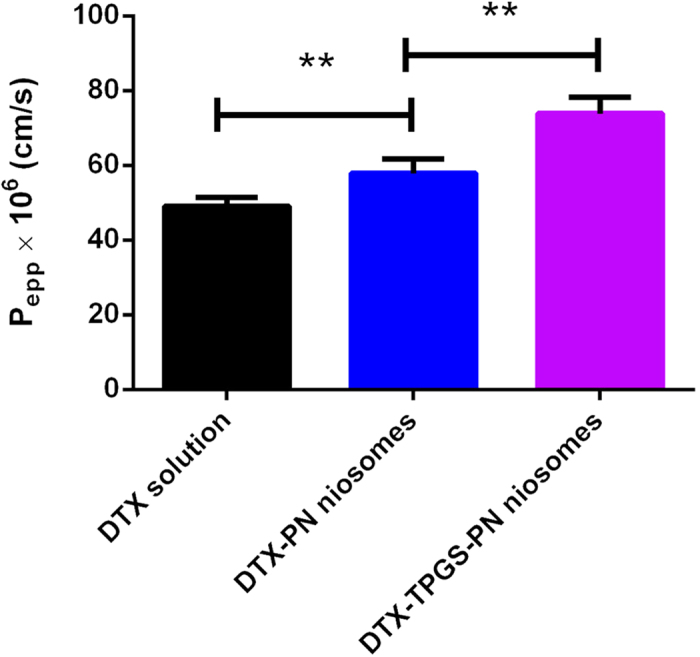
The Peff of DTX solution, DTX-PN and DTX-TPGS-PN niosomes in the single-pass intestinal perfusion model (n = 4, **P<0.05).